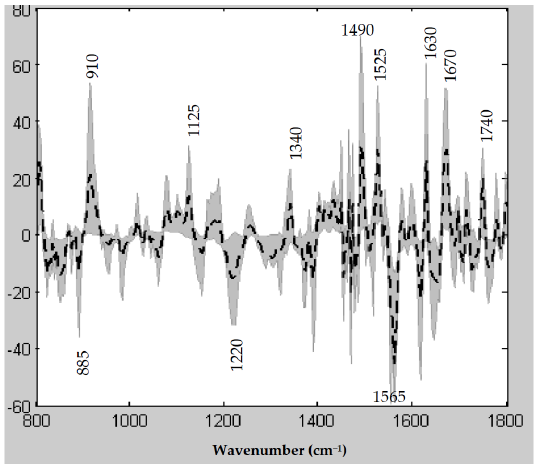
Figure 4. Vibrational infrared features involved in the PLS modeling of the NAC response. The solid line corresponds to the mean of the first twelve PLS latent variables (LV) used in the model and the shaded area represents the minimum to maximum space of variability of these latent variables. The wavenumbers associated with the main spectral features are also